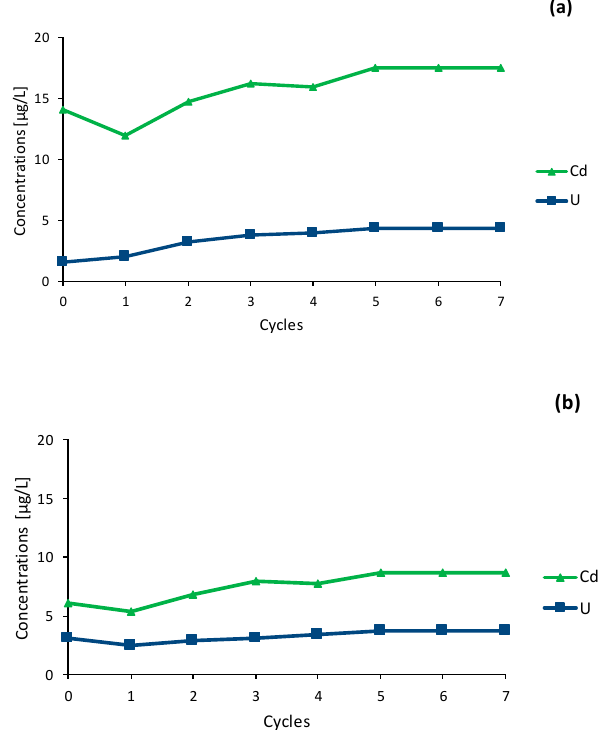
Figure 5. Concentrations of Cd and U in the leachates of the seven batch cycles. ( a ) FW–ZL: fine waste from M’Dhilla-Zone L laundry and ( b ) FW–R: fine waste from Redeyef laundry.